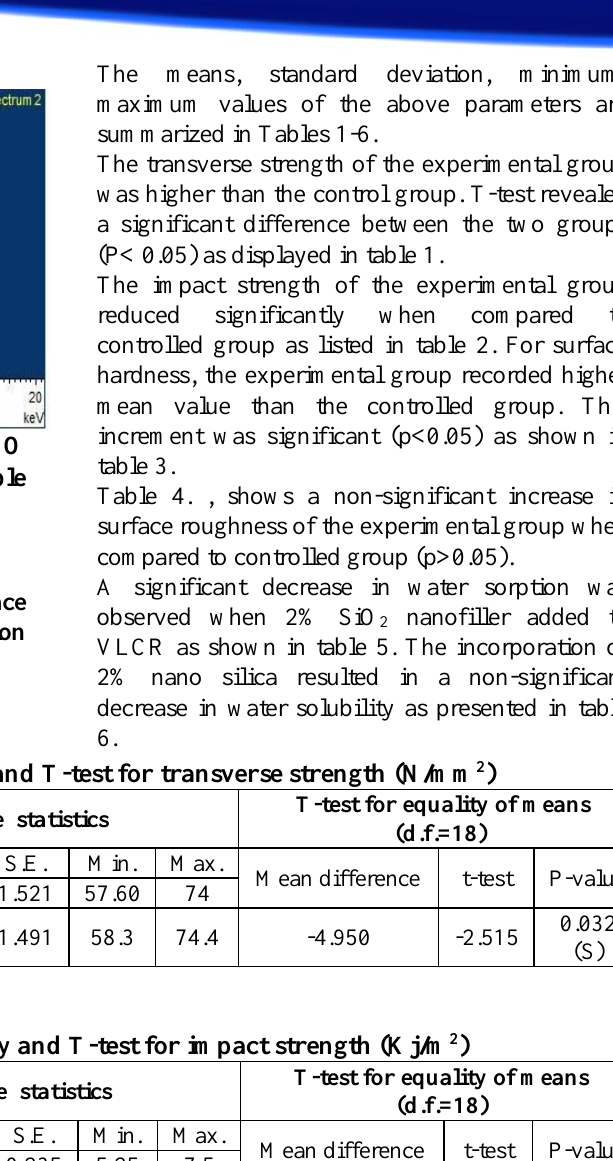
T-test for equality of means (d.f.=18)